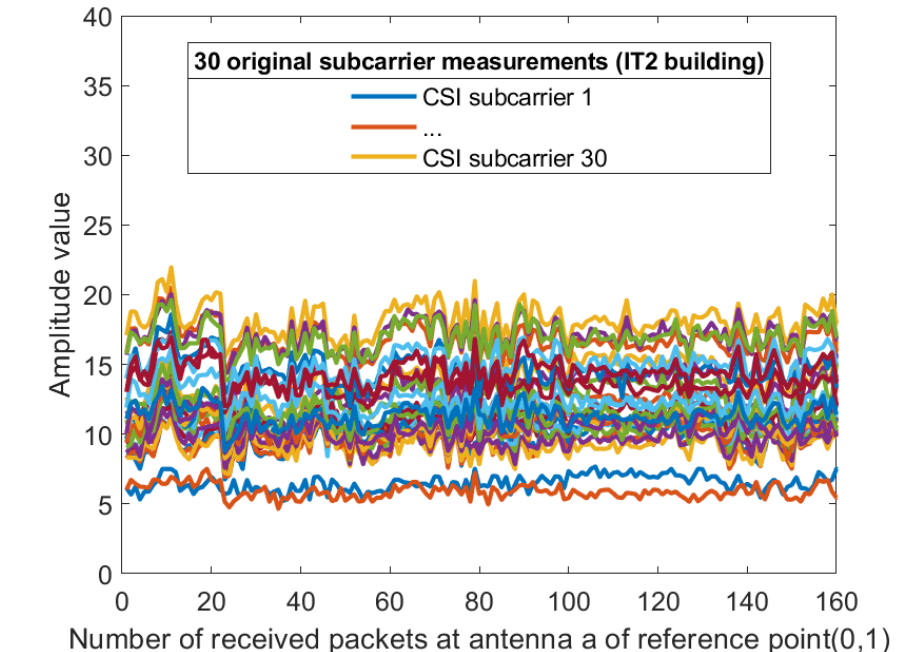
Figure 9. The amplitude of the 30 CSI sub-carriers on antenna a at reference point (0,1) of AP1 in the lobby of IT2